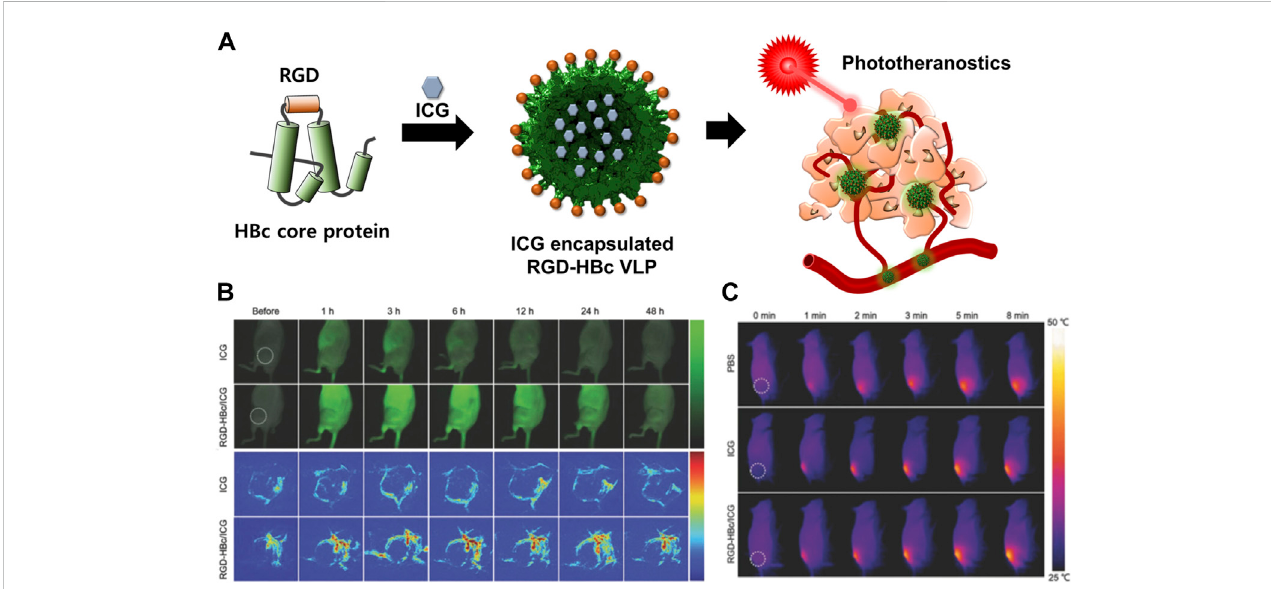
FIGURE 8 (A) Schematic illustration of the preparation and mechanism of action of RGD-HBc/ICG VLPs for cancer therapy and diagnosis. (B) In vivo fl uorescence images of U87MG tumor-bearing mice and photoacoustic images of tumor blood vessels after the intravenous injection of RGD-HBc/ICG VLPs. (C) In vivo